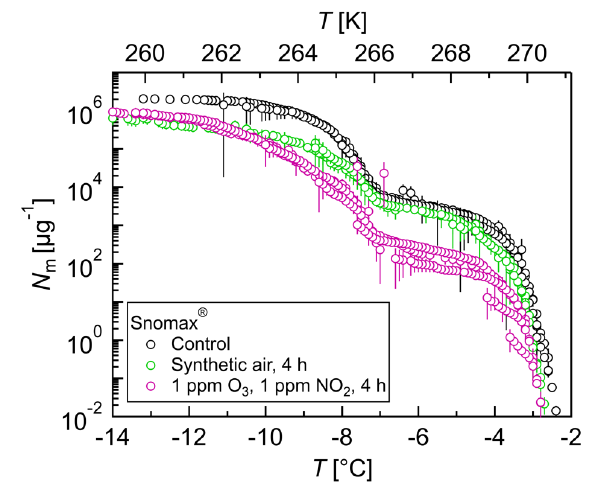
Figure 9. Freezing experiments with ozonized and nitrated bacterial IN. Cumulative number of IN ( N m ) per unit mass of Snomax ® vs. temperature ( T ). Droplets of the same dilution of three independent measurements were added to a total droplet number of 288 (3 × 96 droplets). Symbol colors indicate different exposure conditions. The error bars were calculated using the counting error and the Gaussian error propagation. The temperature error is